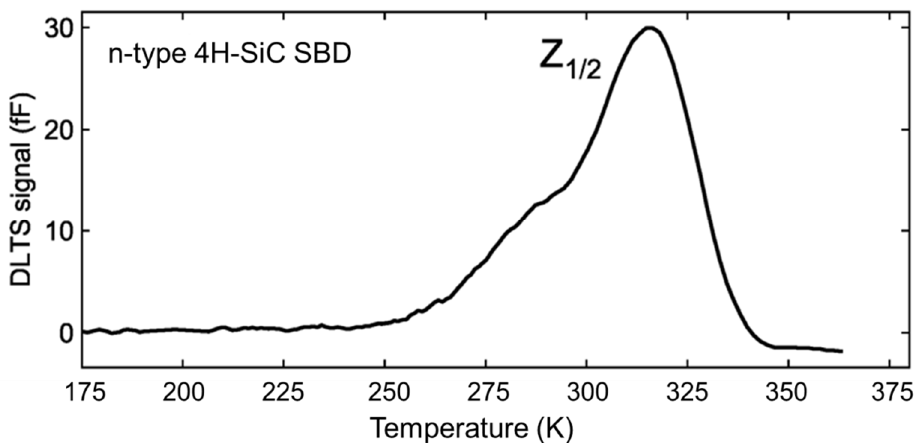
Figure 4. Typical DLTS spectrum for the as grown n ‐ type 4H ‐ SiC SBD. Data adapted from Ref.